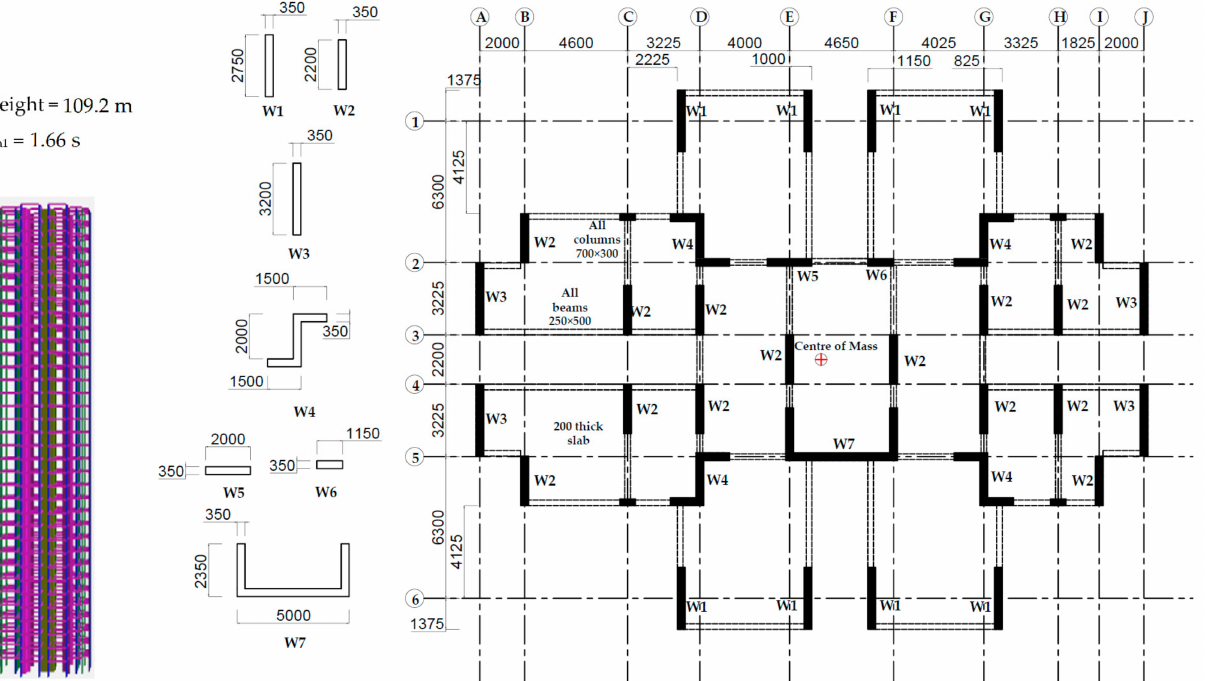
Figure 14. Floor plan, structural layout, and elevation view of CSB 4 (all dimensions are in mm) [29].